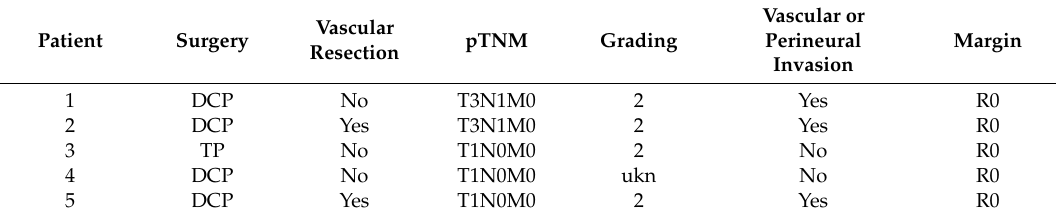
Table 3. Clinico-pathological characteristics of resected